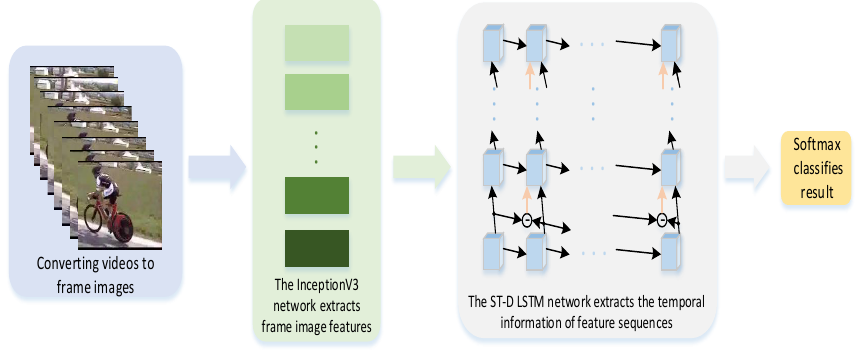
Figure 3. The LRCN network framework based on the ST-D